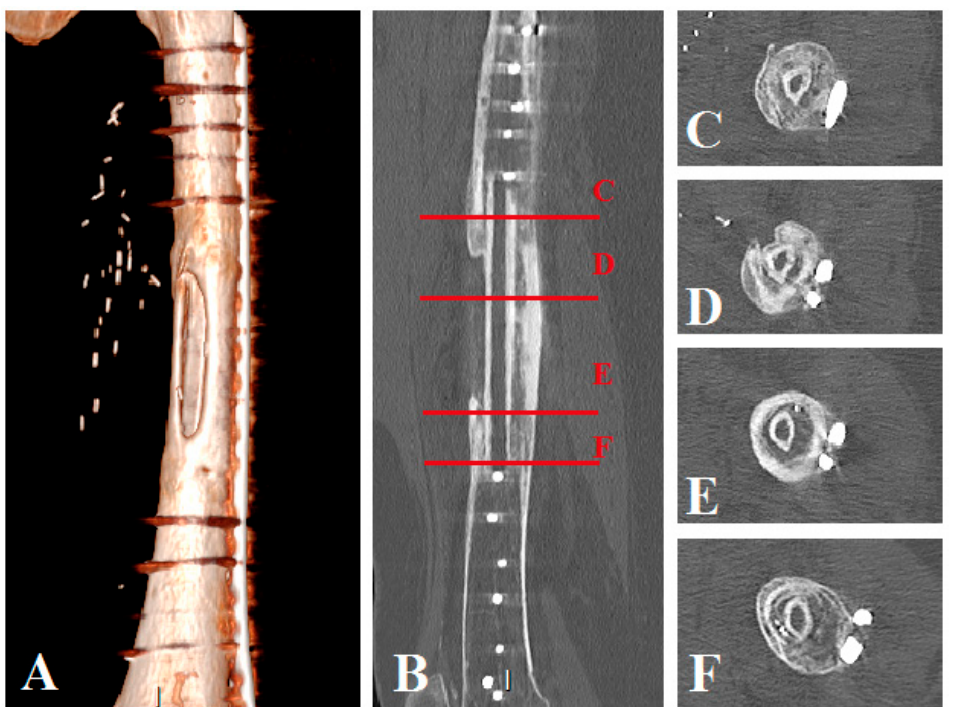
Figure 5. Patient No. 1 CT scan control at 14 months postoperatively: ( A ) CT scan 3D reconstruction of the healed allograft; ( B ) sagittal plane view with axial view level representation: ( C – F ) ( C ) axial view of the proximal host femur with the healed fibula graft, ( D , E ) axial views of the healed fibula graft in the allograft, ( F ) axial view of the distal host femur with the healed fibula graft.